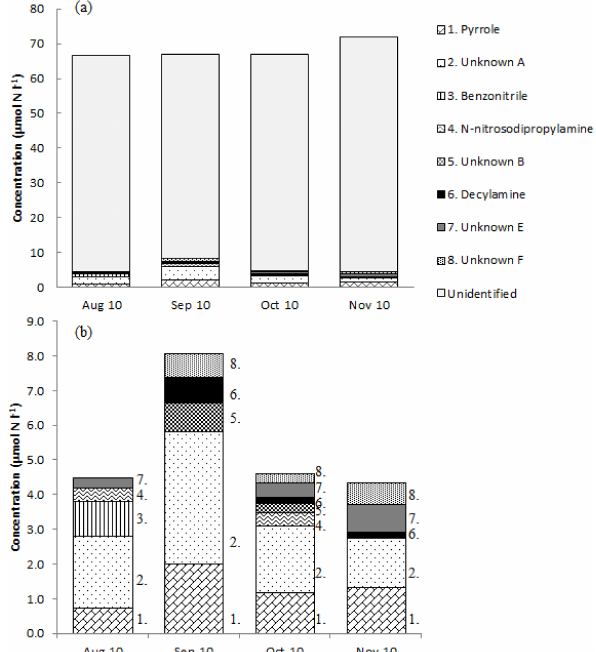
Figure 6. Mean monthly concentrations of the individual com- pounds found in stream water. Panel (a) includes the DON fraction identified from the Antek (white bar) and panel (b) excludes the unidentified fraction, so the fraction detected by GC × GC-NCD is more clearly